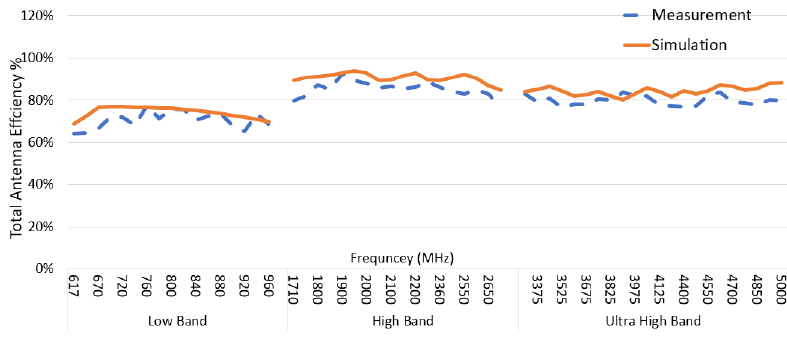
Figure 16. AUT total efficiency for prototype measurement and simulation data.